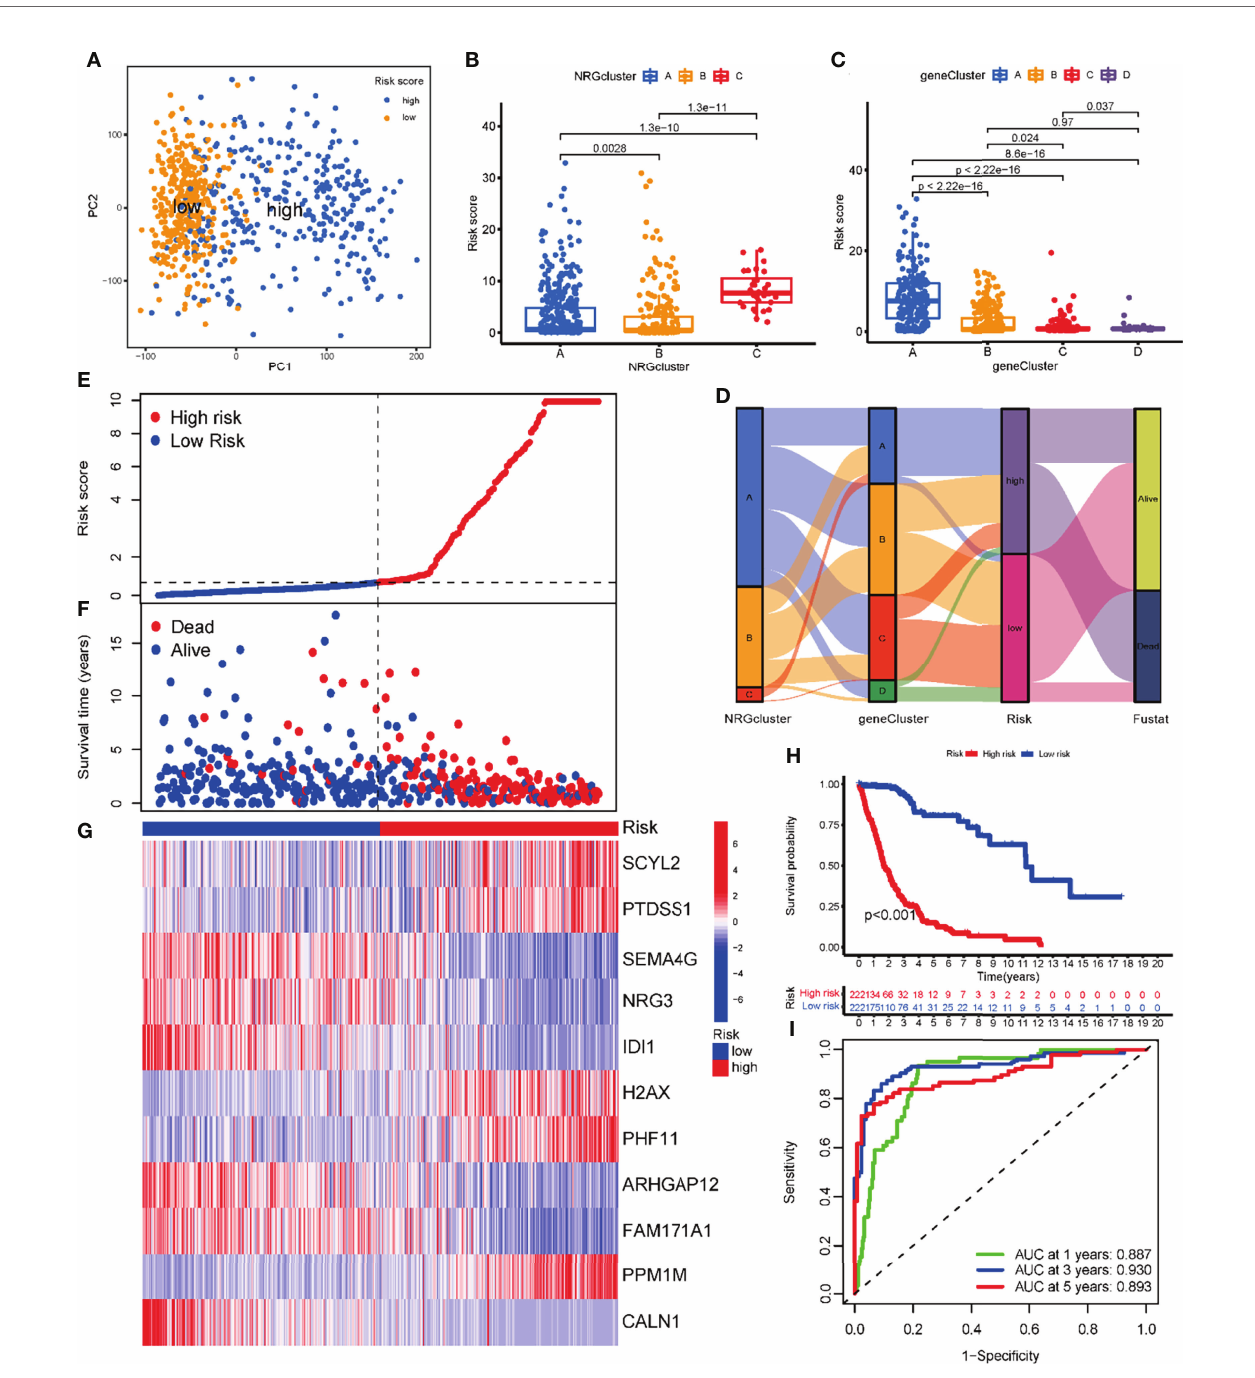
FIGURE 7 | Development of the risk NRG_score in the training dataset. (A) PCA analysis based on the NRG_score. The blue and yellow dots represent the high- and low-risk groups, respectively. (B) Comparison of NRG_score in different NRGclusters. (C) Comparison of NRG_score in different geneClusters. (D) Alluvial diagram of the distribution of subtypes with different NRG_score and survival outcomes. (E) The ranked dot of the distribution of the NRG_score. (F) Scatter plots of the distribution of the survival status in patients from high- and low-risk groups. (G) The expression of genes in the NRG_score model in patients from two risk groups. (H) Kaplan-Meier survival analysis of the two risk groups. (I) ROC curves of the NRG_score model for predicting the sensitivity and speci fi city of 1-, 3-, 5- year survival in patients with